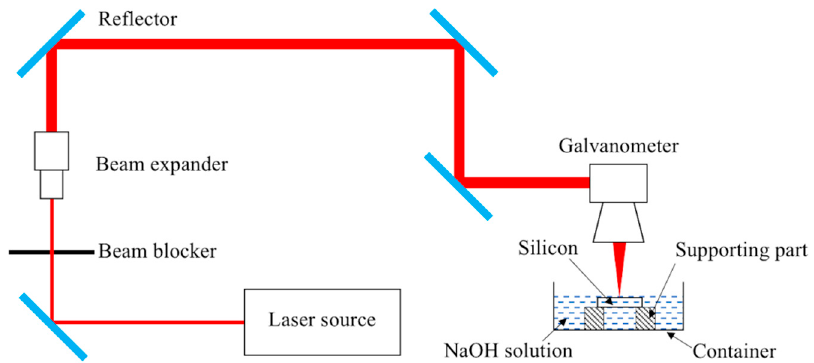
Figure 1. Schematic of the picosecond laser micro-trepanning system.